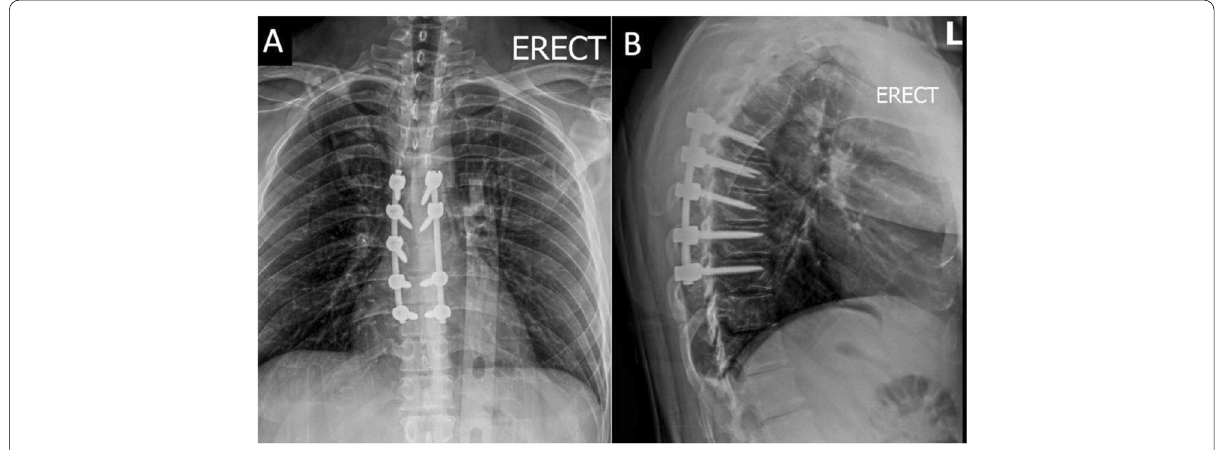
Fig. 4 Postoperative ( A ) AP and ( B ) lateral X